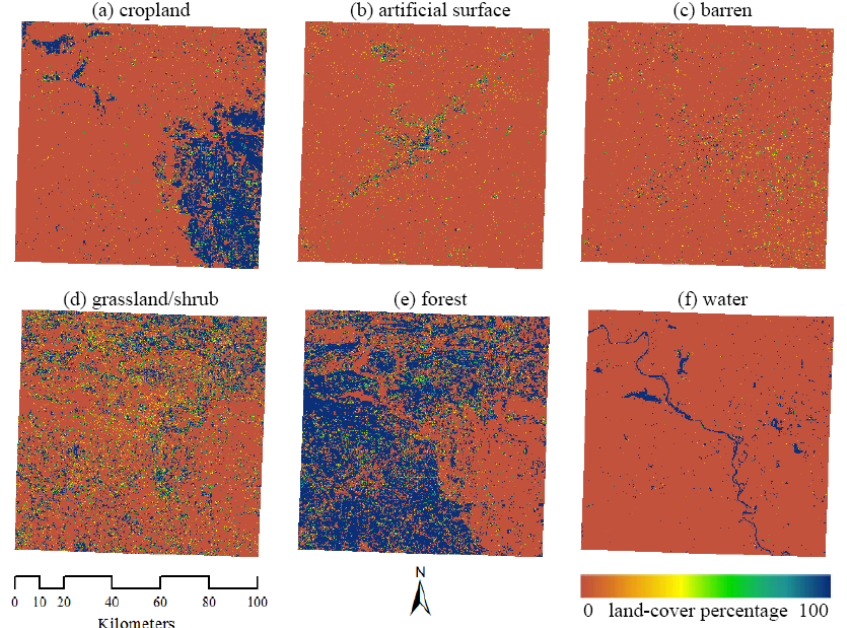
2 . Land cover percentages (2010; 30-m resolution) generated by the sub-pixel classification.